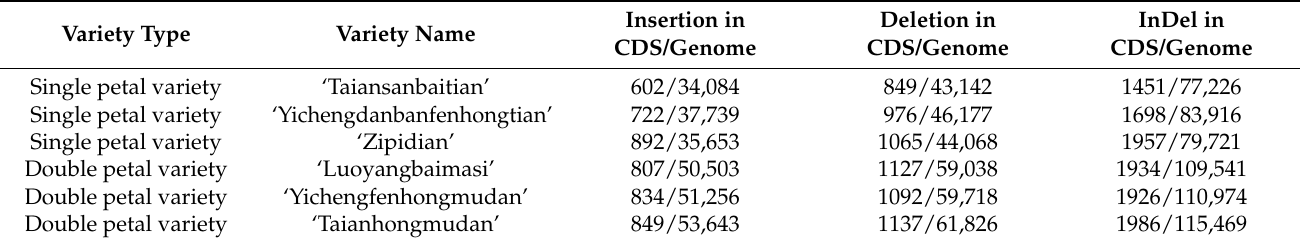
Table 4. Annotation statistics of InDels in six varieties.